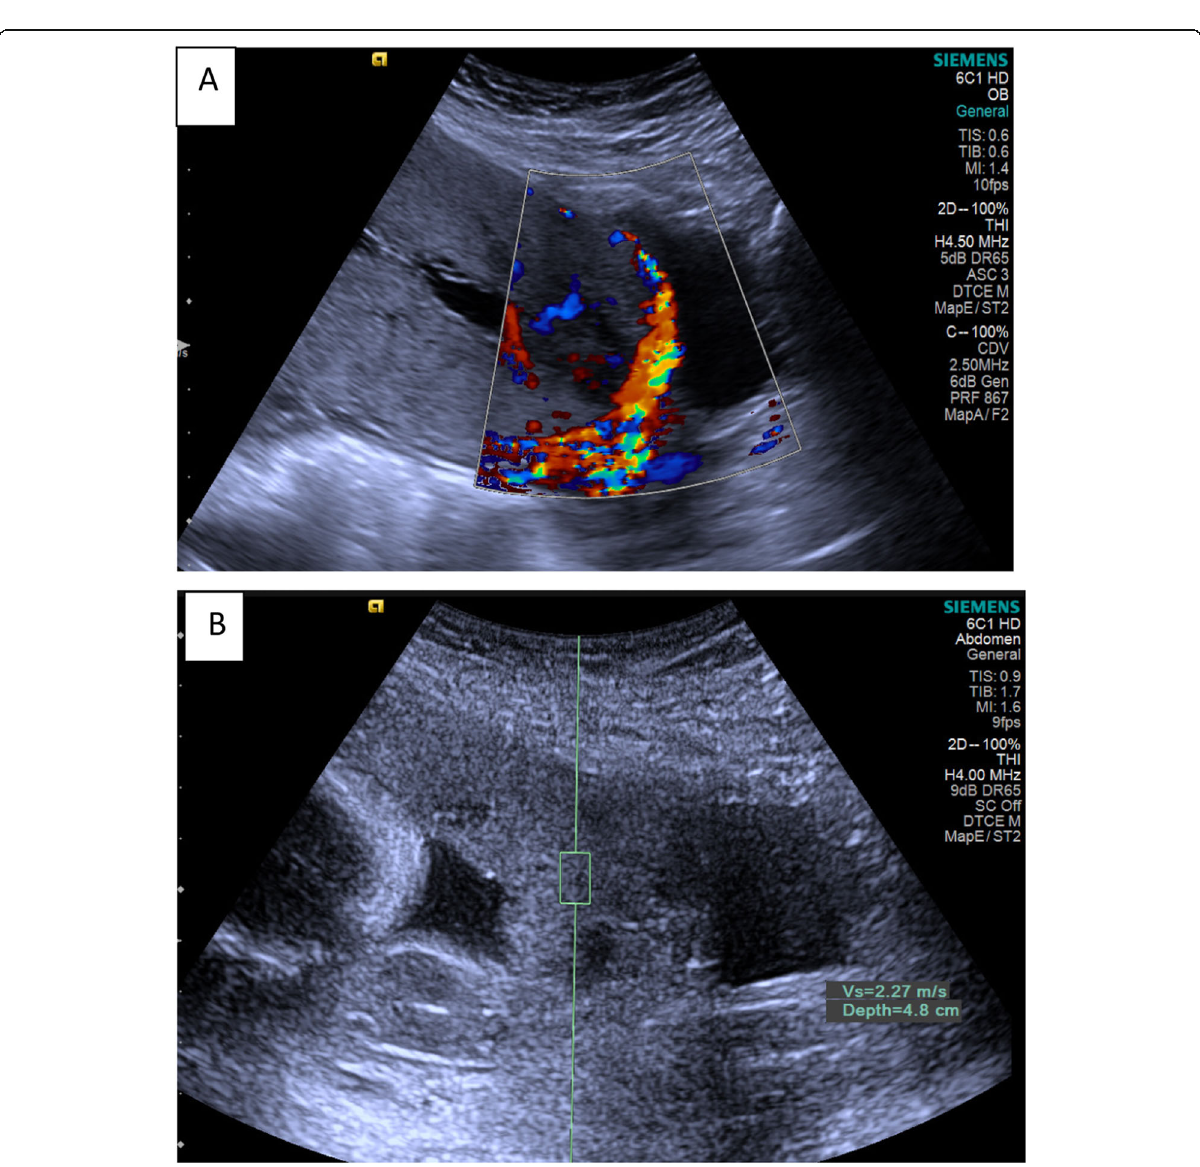
Fig. 5 Pregnancy with placenta preavia and accreta, gestational age 27 weeks. a Color Doppler ultrasound shows placenta previa centralis, with lamellated flow in the utero-vesical pouch. b SWV = 2.27 m/s, depth 4.8 cm. In the current, the pregnancies with placenta accreta showed significant increased SWV (elasticity) than normal placenta